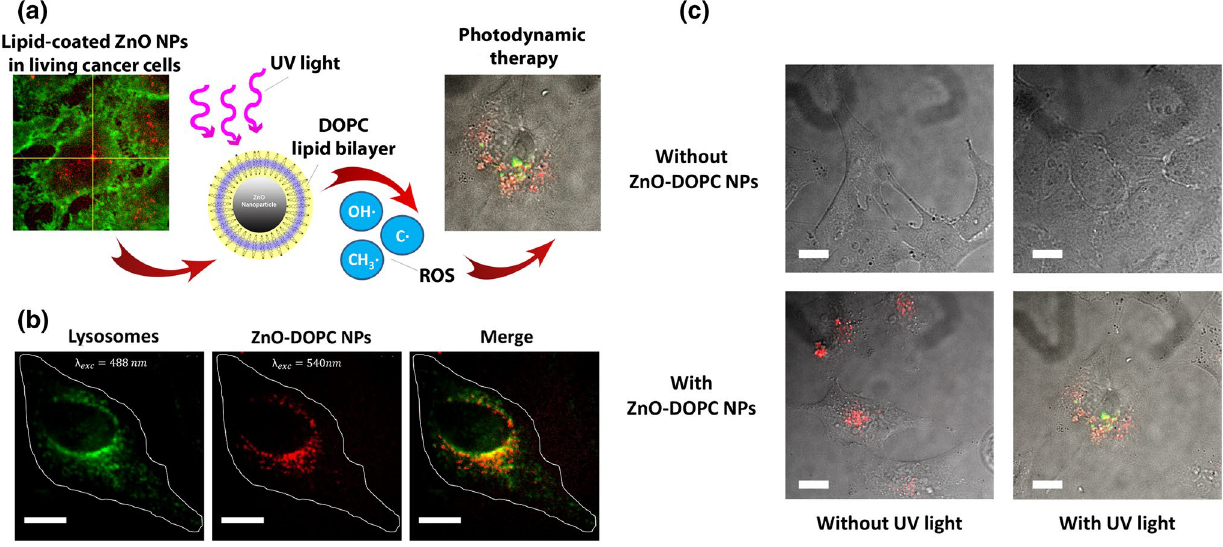
Fig. 9 a Schematic representation of PDT with lipid coated zinc oxide NPs (ZnO-DOPC NPs). b Fluorescent-labeled (Atto550-NHS) ZnO- DOPC NPs colocalization with lysosomes labeled with Lysosomes-GFP. c ROS generation measurement through the 2 ′ –7 ′ dichlorofluorescein diacetate assay. Scale bars: 5 μm. Reprinted under a Creative Common Licence CC-BY 4.0. Copyright 2020 from Ref.